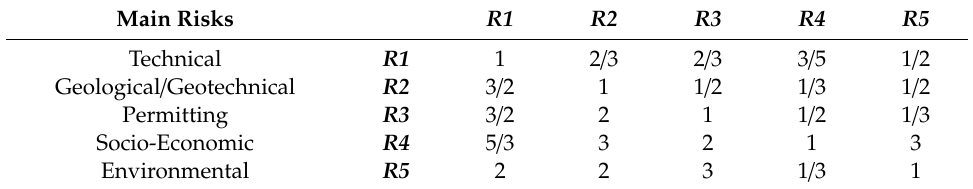
Table 9. Analytical hierarchy process (AHP) Reciprocal